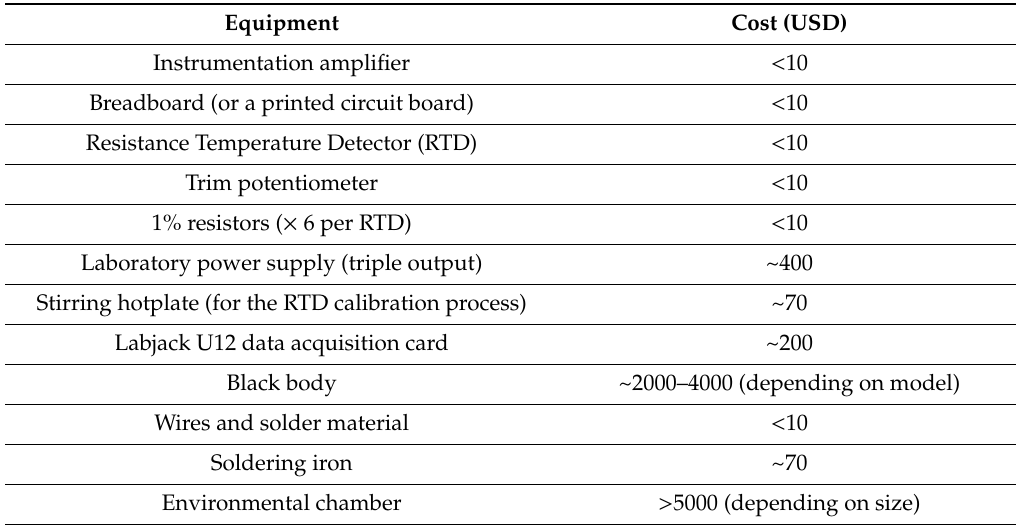
Table 1. Equipment and associated approximate costs used to develop the temperature radiometric calibration functions for the thermal infrared